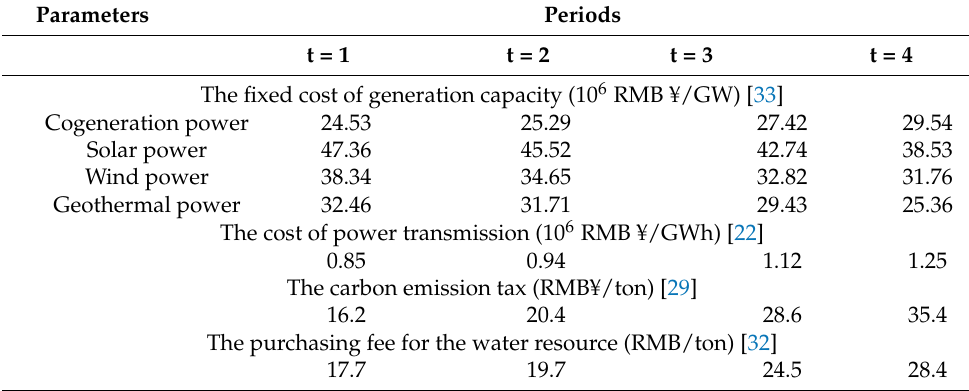
Table 2. The key economic and technique data.